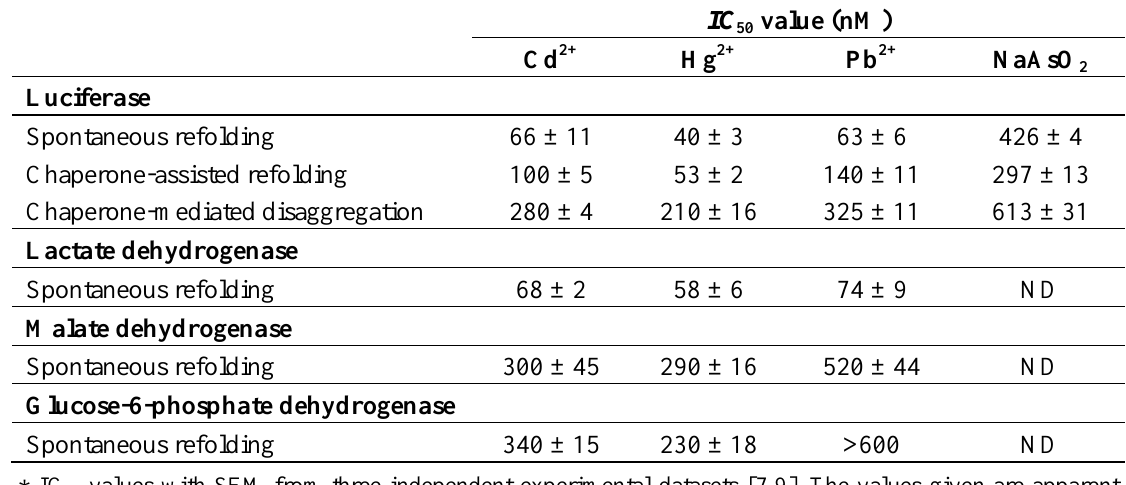
* IC values with SEM from three independent experimental datasets [7,9]. The values given are apparent 50 values determined at a protein concentration of 350 nM (see text). ND: not